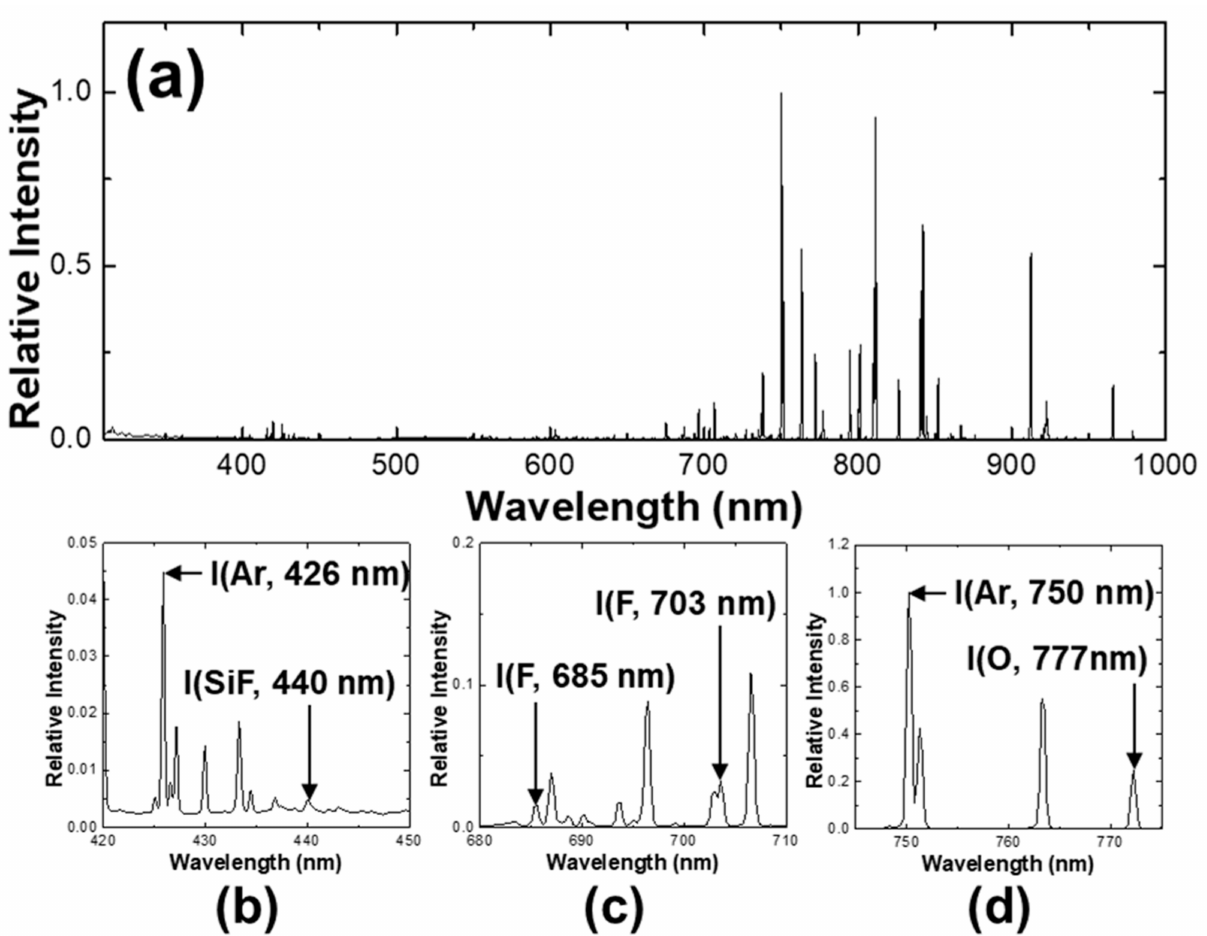
Figure 3. ( a ) OES full spectrum taken from SF 6 /O 2 /Ar plasma (operating conditions: 120/75/50 sccm, top main power 60 MHz 500 W, Btm bias power 2 MHz 150 W); ( b ) 426 nm of Ar emission and 440 nm of SiF emission; ( c ) 685 and 703 nm of F emission; ( d ) 750 nm of Ar emission and 777 nm of O emission. Details of each optical emission signal are described in Tables A1 and A2 of Appendix